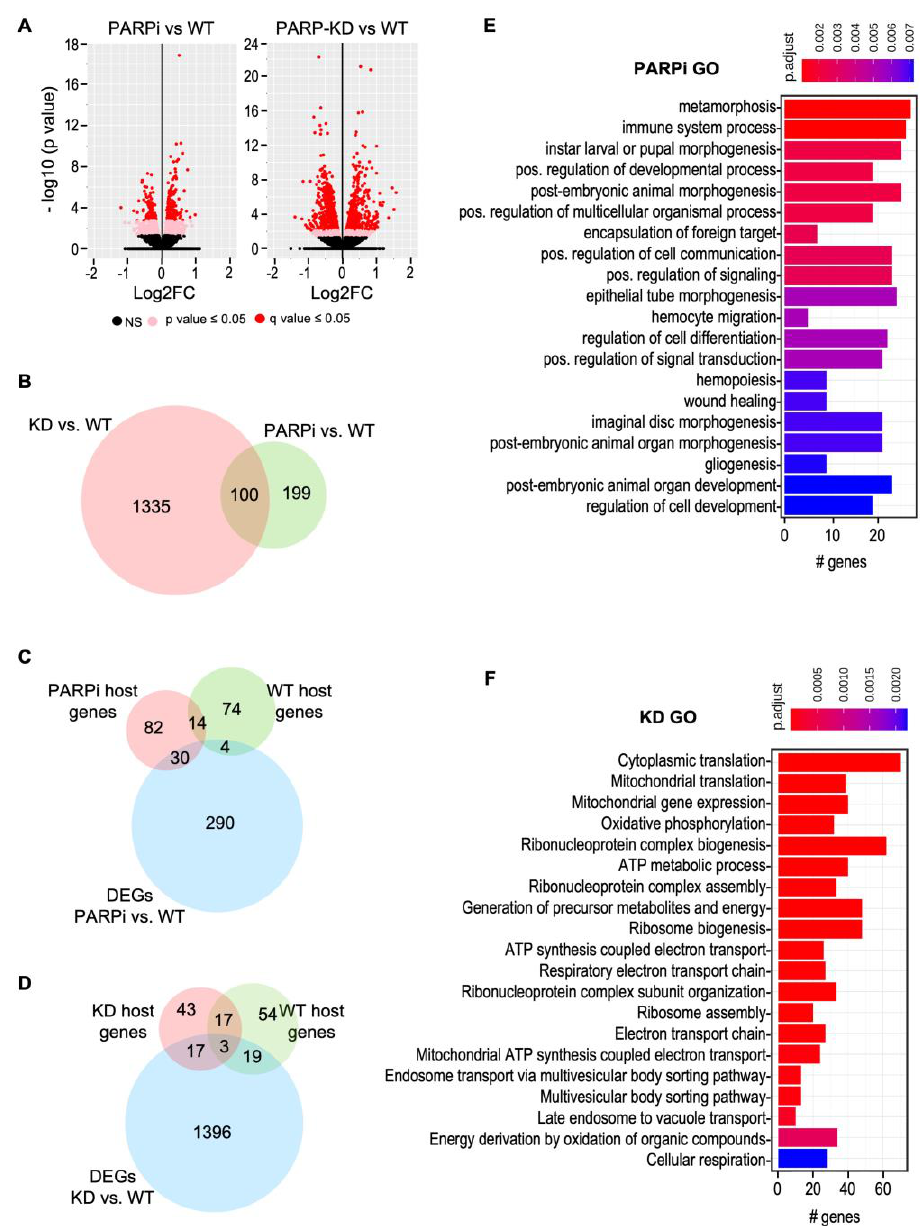
Figure 2. Gene regulation mediated by PARP1 and PARylation. ( A ) Volcano plots showing differentially expressed genes in PARPi and PARP KD vs. WT conditions. Y-axis is -log p -value and x-axis is the log2 value of the fold change. Each dot represents one gene. Black dot represents no significant difference, pink represents p < 0.05, red dot represents q value < 0.05. ( B ) Venn diagram showing the DEGs that overlap between PARP KD (pink) compared to inhibition of its PARylation activity (green). ( C ) Venn diagram showing PARPi host genes (red) compared with WT host genes (green) and genes differentially expressed in PARPi (blue). ( D ) Venn diagram of PARP KD host genes (red), WT host genes (green), and genes differentially expressed in PARPi (blue). Numbers depicted in the intersections between circles represent the numbers of genes that are commonly regulated in two, three, or four conditions. ( E , F ) Top 20 enriched GO biological processes ranked by significance for PARP1 ( E ) and PARP KD ( F ).